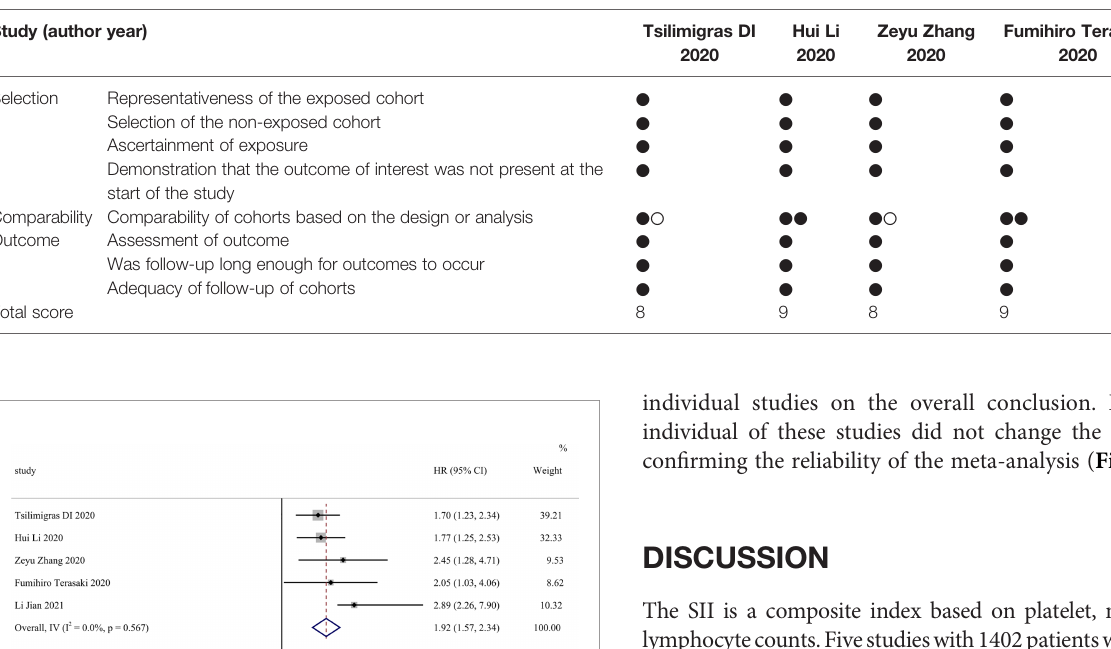
TABLE 2 | Items of NOS of included studies in the meta-analysis.